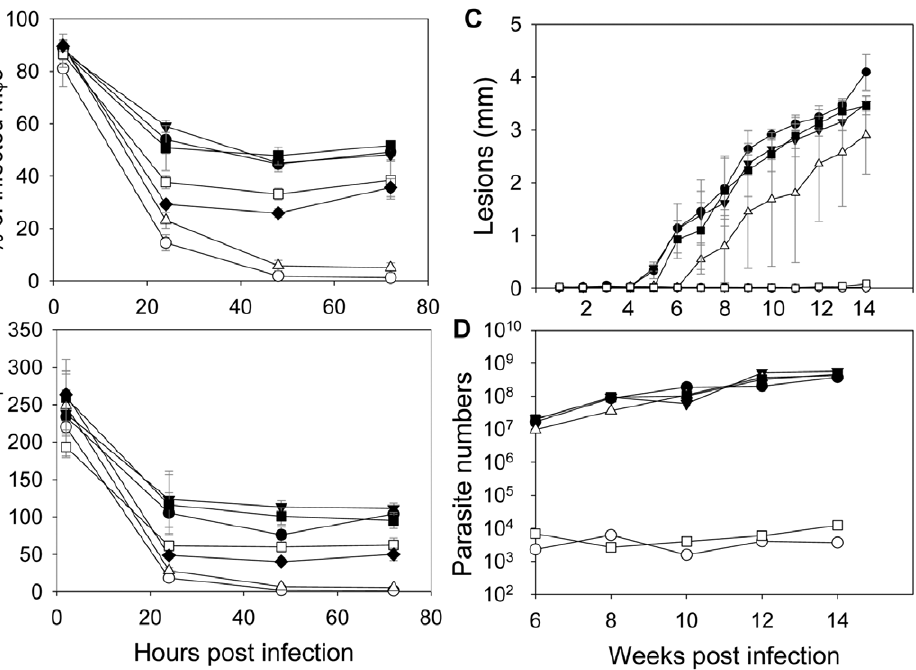
N Figure 6. The SMase activity alone was sufficient to restore virulence in iscl 2 . ( A–B ) Bone marrow-derived M w s from BALB/c mice were : WT, # : iscl 2 , . : iscl 2 / + HA-ISCL, & : iscl 2 / + CnISC1, % : iscl 2 / + HA-BcSMase, X : iscl 2 / + 5 9 HASPb- infected by stationary phase promastigotes ( N BcSMase-HA, n : WT + activated M w s) at a ratio of 15 parasites per M w . Percentages of infected M w s ( A ) and the number of parasites in 100 M w s ( B ) : WT, # : iscl 2 , . : iscl 2 / + HA-ISCL, n : iscl 2 / were recorded. ( C–D ) BALB/c mice were infected in the footpads with day 3 stationary promastigotes ( + HA-BcSMase, & : iscl 2 / + 5 9 HASPb-BcSMase-HA, % : iscl 2 / + CnISC1) at 1 6 10 6 parasites per mouse (5 mice per group). Lesion sizes were measured with a caliper ( C ) and parasite numbers in infected footpads were determined by the limiting dilution assay ( D ). Error bars represent standard deviations from 2 independent experiments.